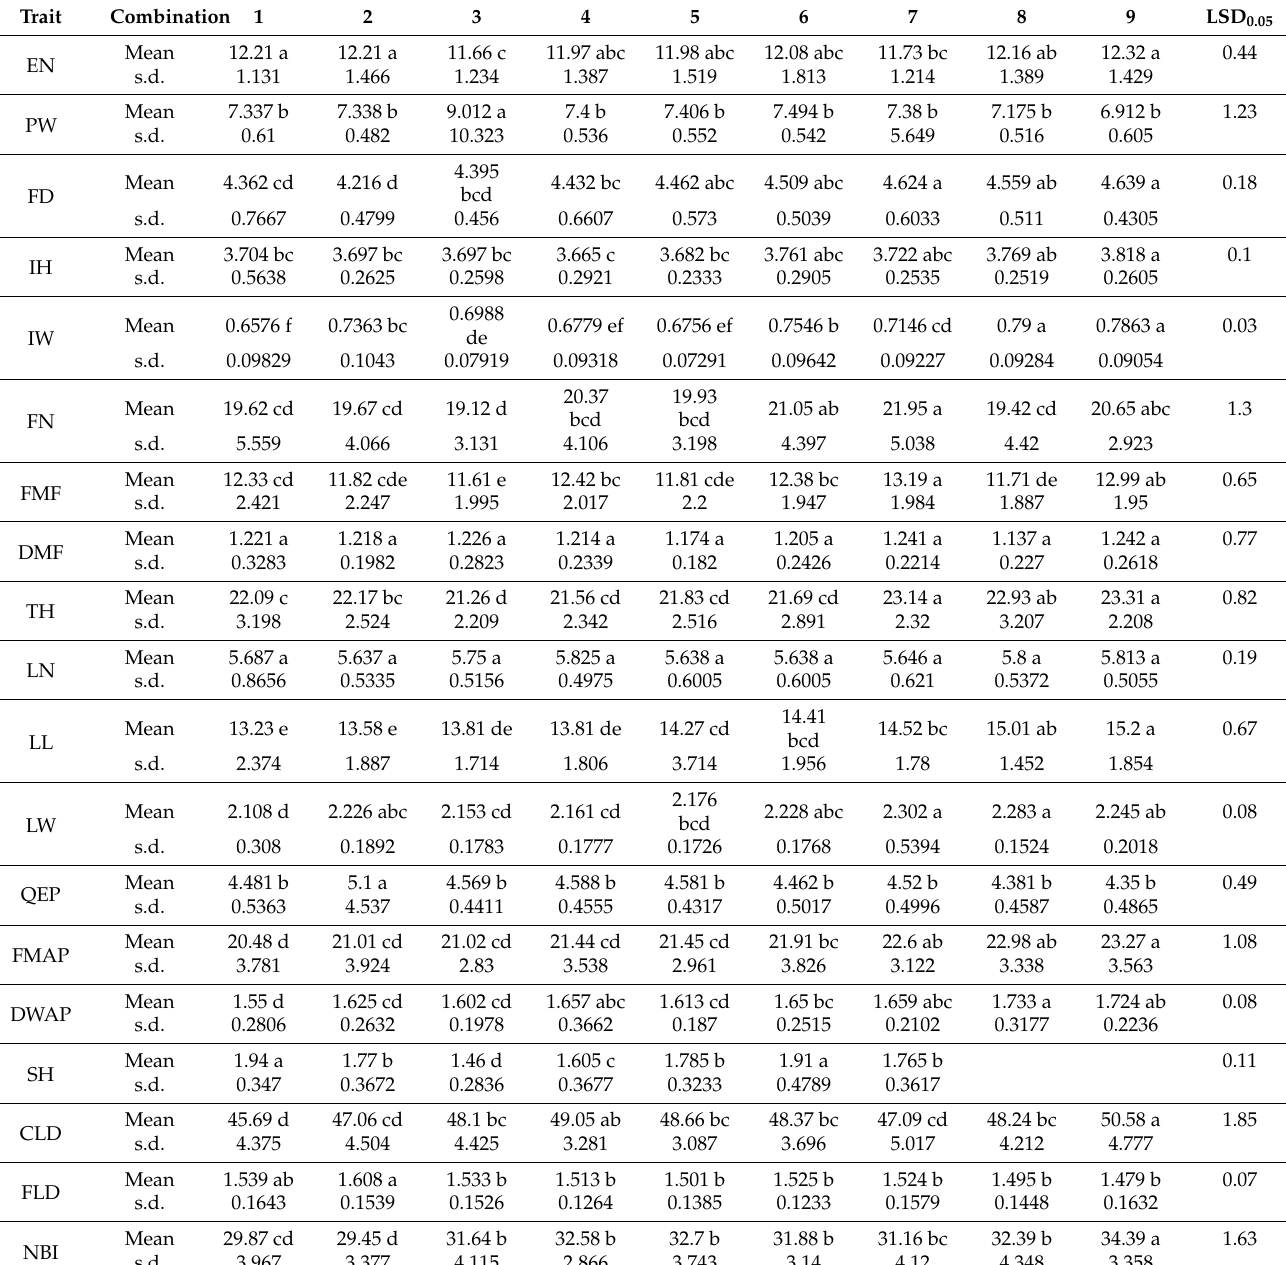
Table 5. Mean values, standard deviations (s.d.), Fisher’s least significant differences (LSD) and homogeneous groups of observed traits for